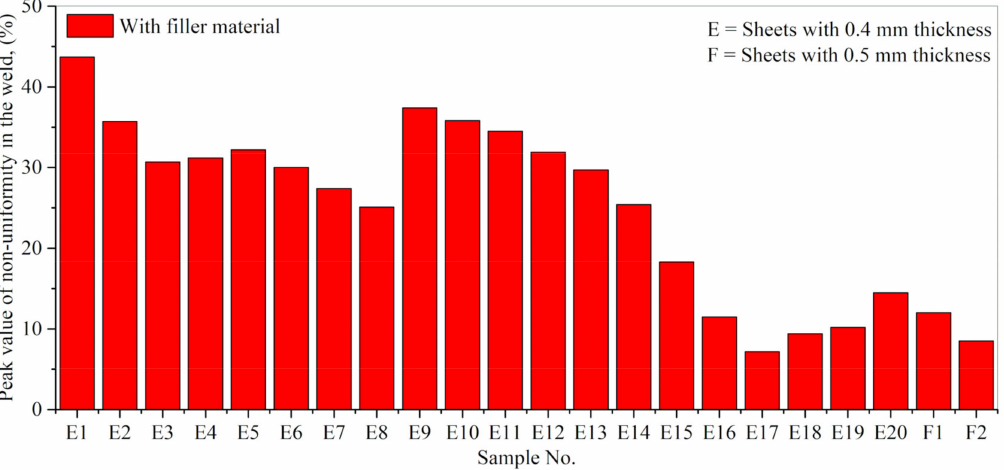
Figure 16. The peak value of non-uniformity was calculated via X-ray analyses for laser welds with filler material (Inconel